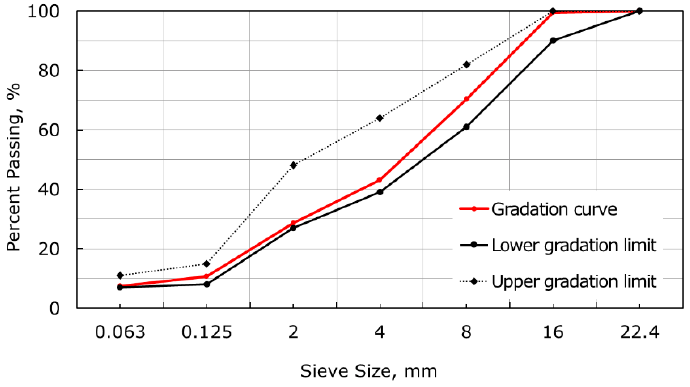
Figure 1. The gradation curve for the asphalt mixture.